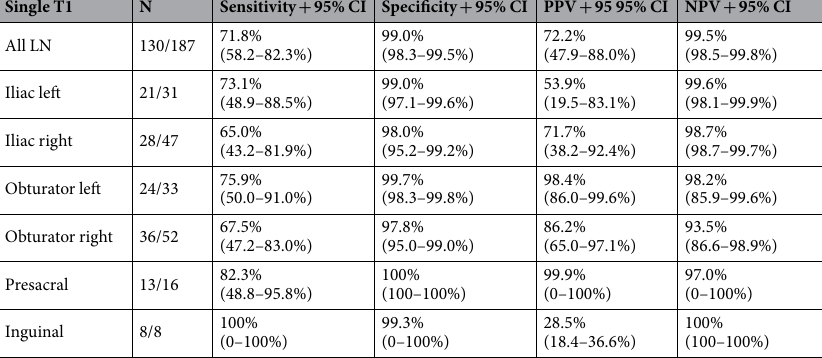
Table 4. Overall and region-based detection rate using single T1 sequence MRI evaluation. This table summarizes the region-based analysis of the lymph node metastases in MRI using single T1 sequence evaluation. The columns present number, sensitivities, specificities, positive and negative predictive value including 95% confidence interval. The rows are fielded in the six defined anatomical regions iliac left and right, obturator left and right, presacral and inguinal region. Abbreviations: LN = Lymph nodes, N = number of positive LN in MRI versus PET-CT, PPV = positive predictive value, NPV = Negative predictive value, CI = 95%